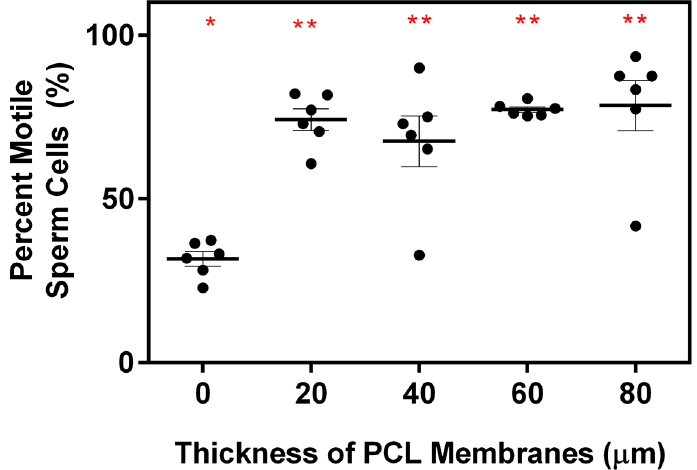
Figure 3. Motile sperm cell population isolated from unfiltered and solution electrospun PCL membranes with different thickness ( N = 6). Asterisk above show groups with no significant differences in means as evaluated using one way ANOVA and Tukey’s multiple comparison